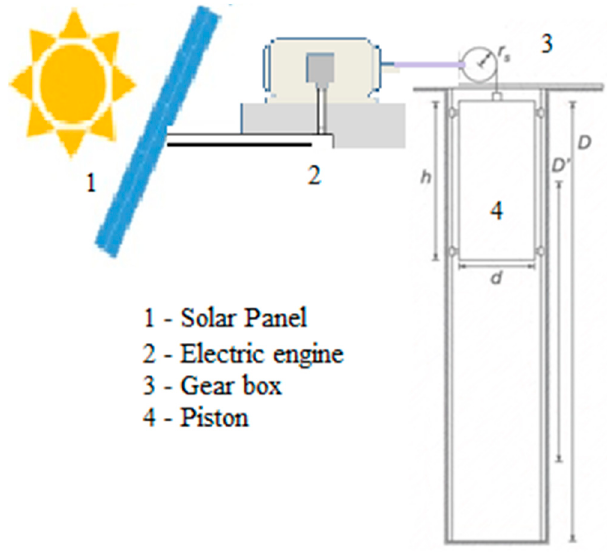
Figure 2. Small scale gravity energy storage system using piston.